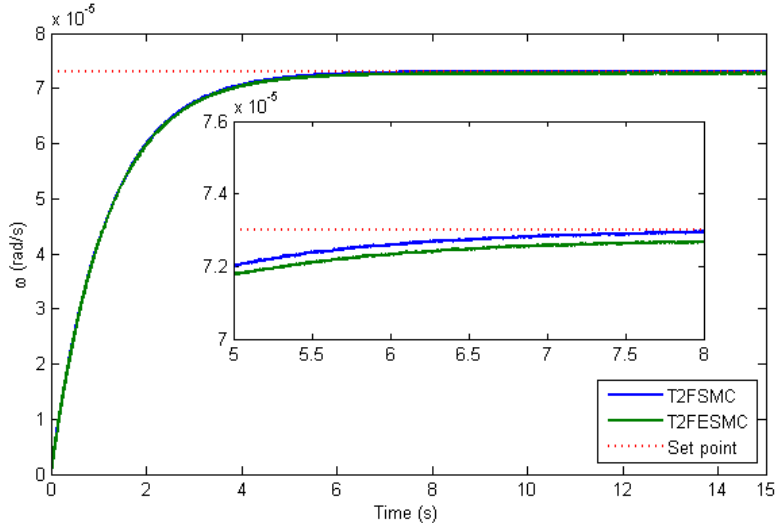
Fig. 5: Simulation of the new fuzzy inference system with the dc motor equation.